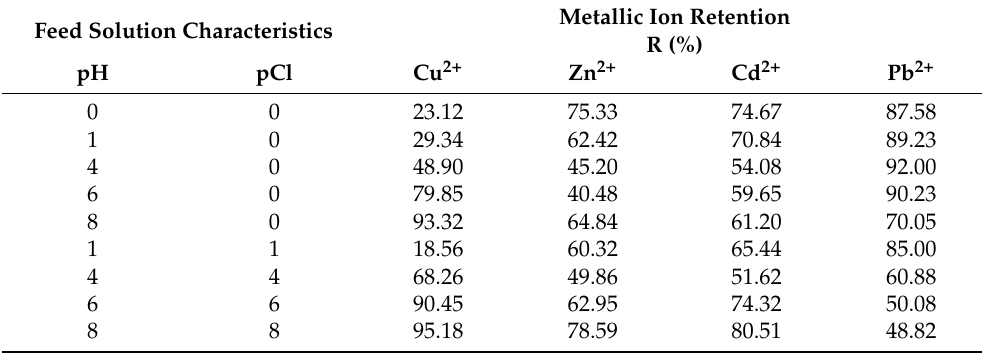
Table 4. Separation efficiency (retention) of copper, zinc, cadmium, and lead ions from aqueous solutions, depending on the pH and